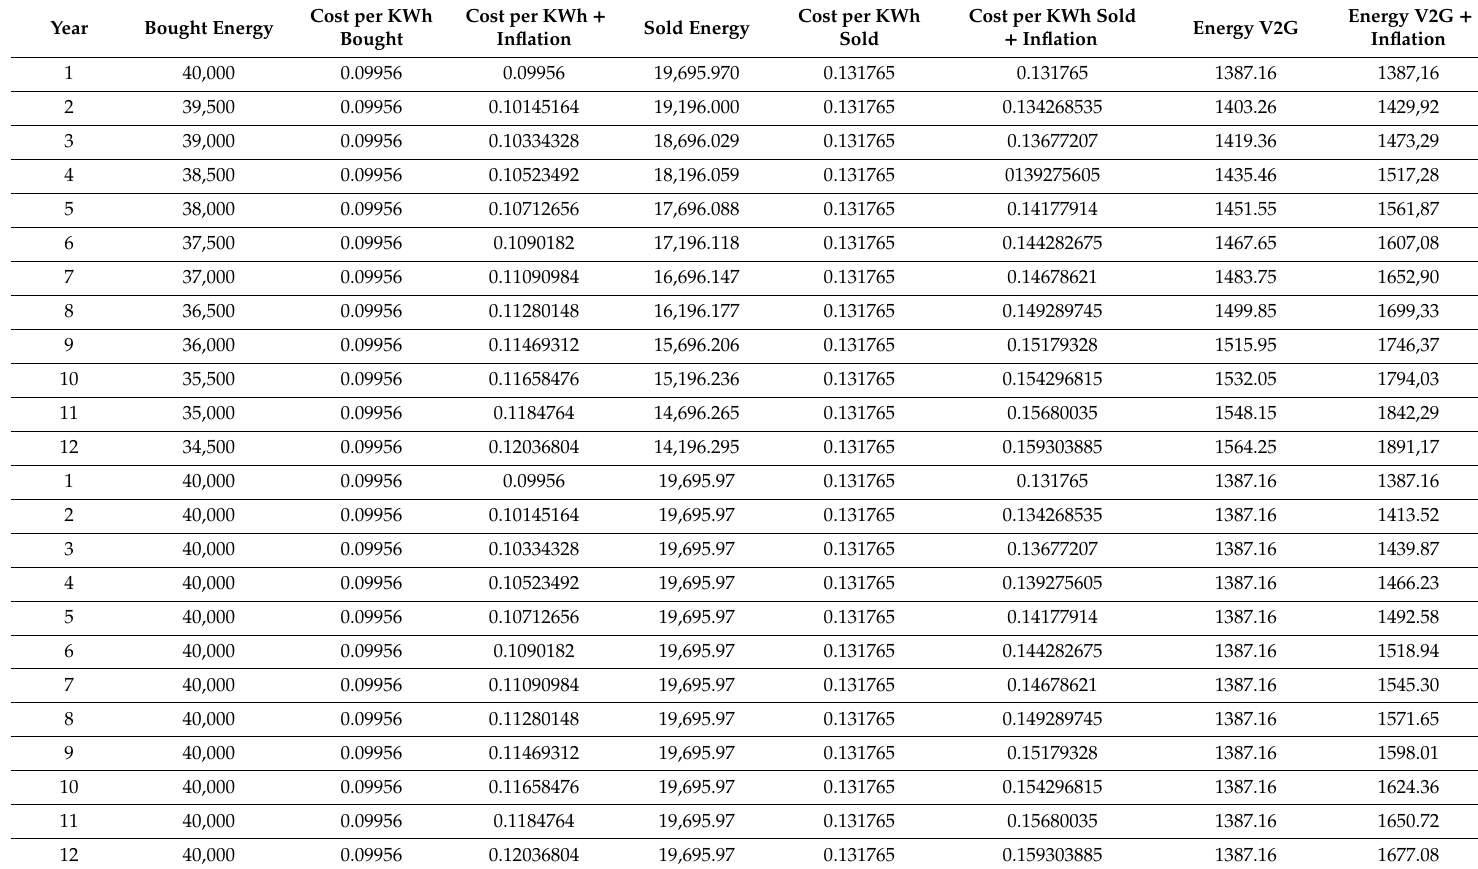
Table A5. Costs / profits with and without yearly degradation (professional